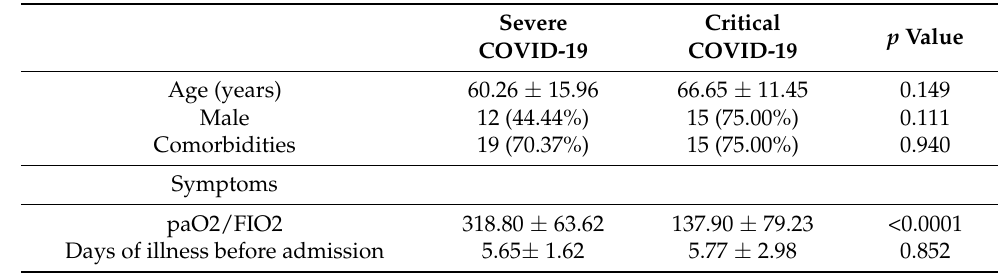
Table 1. Patient clinical and demographic